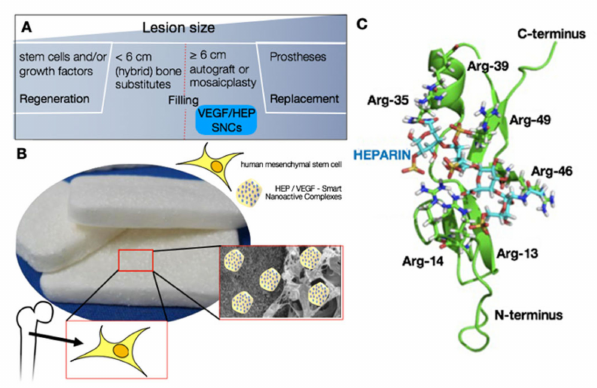
Figure 1. Third-generation hybrid bone substitute nano-functionalized with pro-angiogenic molecules. ( A ) Current strategies for bone repair. ( B ) The combination of pro-angiogenic smart nano-active complexes (SNCs), human mesenchymal stem cells, and biphasic bone substitute used in this study. ( C ) Molecular modeling of the HEP/VEGF complex, where VEGF is displayed as homology model (green), and HEP as stick model (blue). Sulfur moieties are shown in